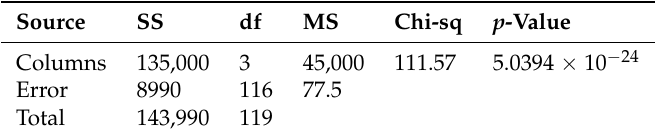
Table 5. Computational times Kruskal–Wallis